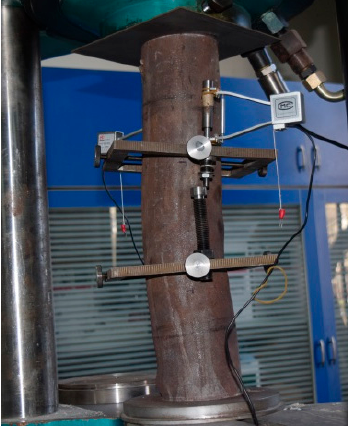
Figure 9. Failure modes of C-N-T1.